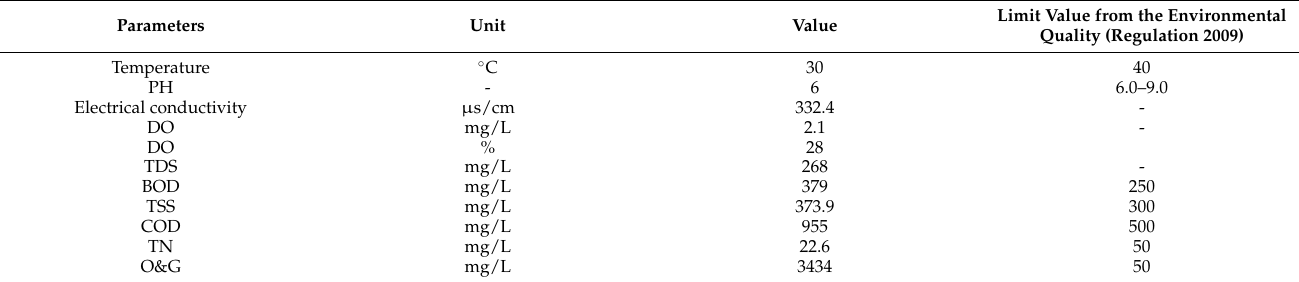
Table 2. Characterisation of the restaurant wastewater .